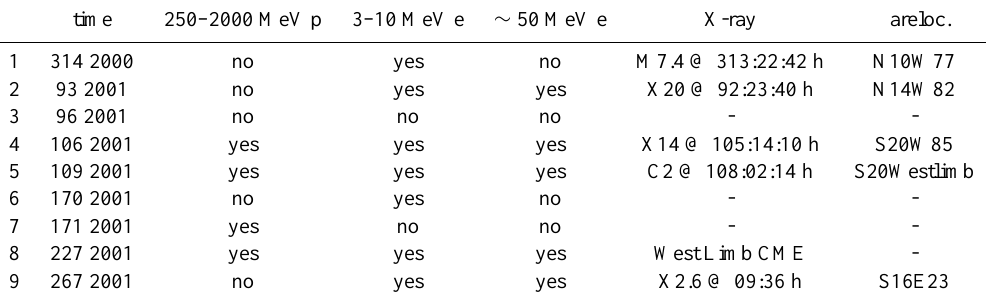
Table 3. List of major solar particle events observed by the KET on board Ulysses. Flare onset times and location taken from Dalla et al. (2002), and